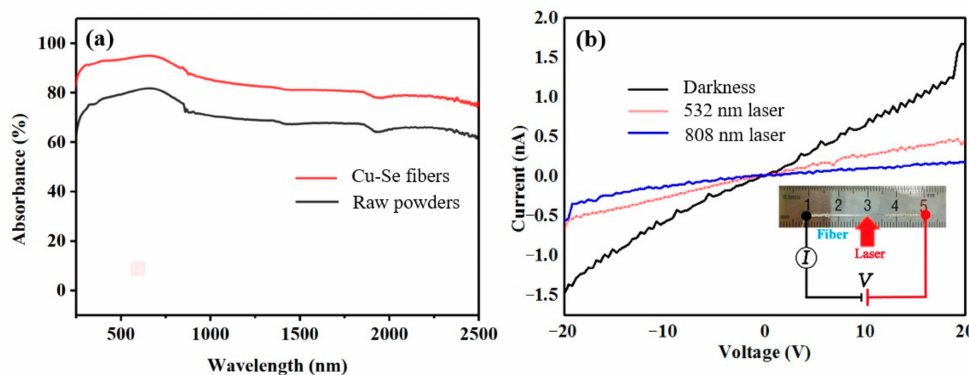
Figure 3. ( a ) Absorbance spectra for CuSe raw powders and Cu-Se core fibers; and ( b ) the current- voltage curves of a Cu-Se core fiber in dark and irradiated conditions. Inset of ( b ) is the optical graph of a Cu-Se fiber and schematic of the electrical